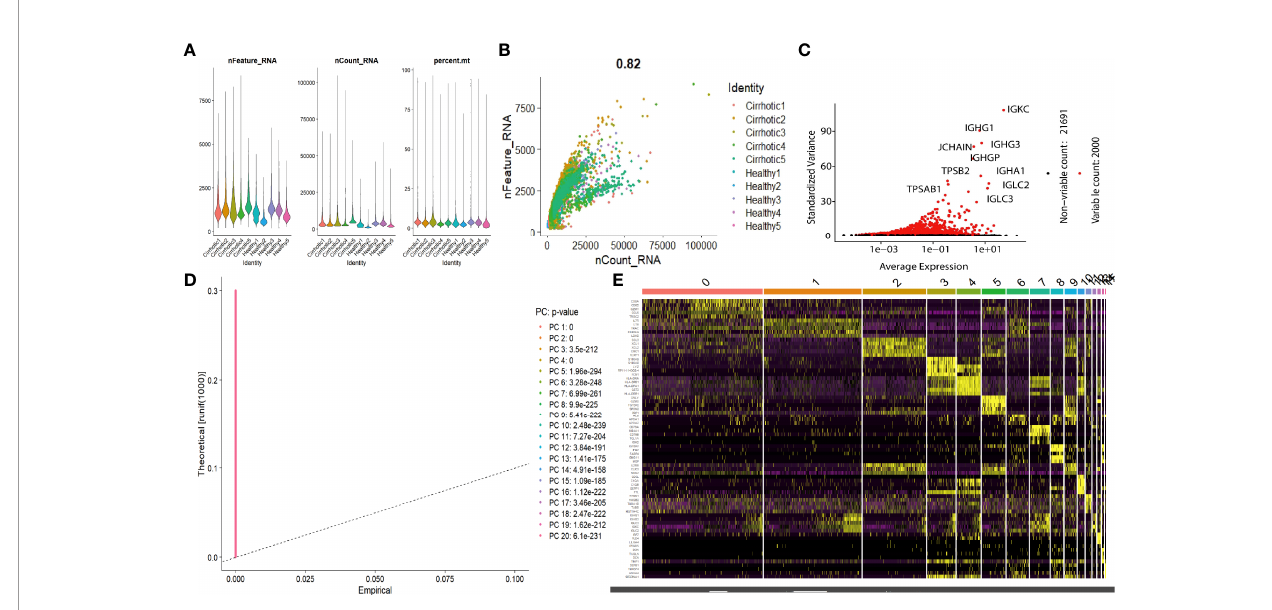
FIGURE 1 | scRNA analysis of liver cirrhosis. (A) The gene features, gene counts, and mitochondrial gene percentage of each sample. (B) Correlation between genes and counts in each sample. (C) HVGs are colored red, and the top 10 HVGs are labeled. (D) PCs selection using the JackStraw function. (E) Heatmap of the top 5 DEGs in each cluster. The top 5 DEGs are labeled in